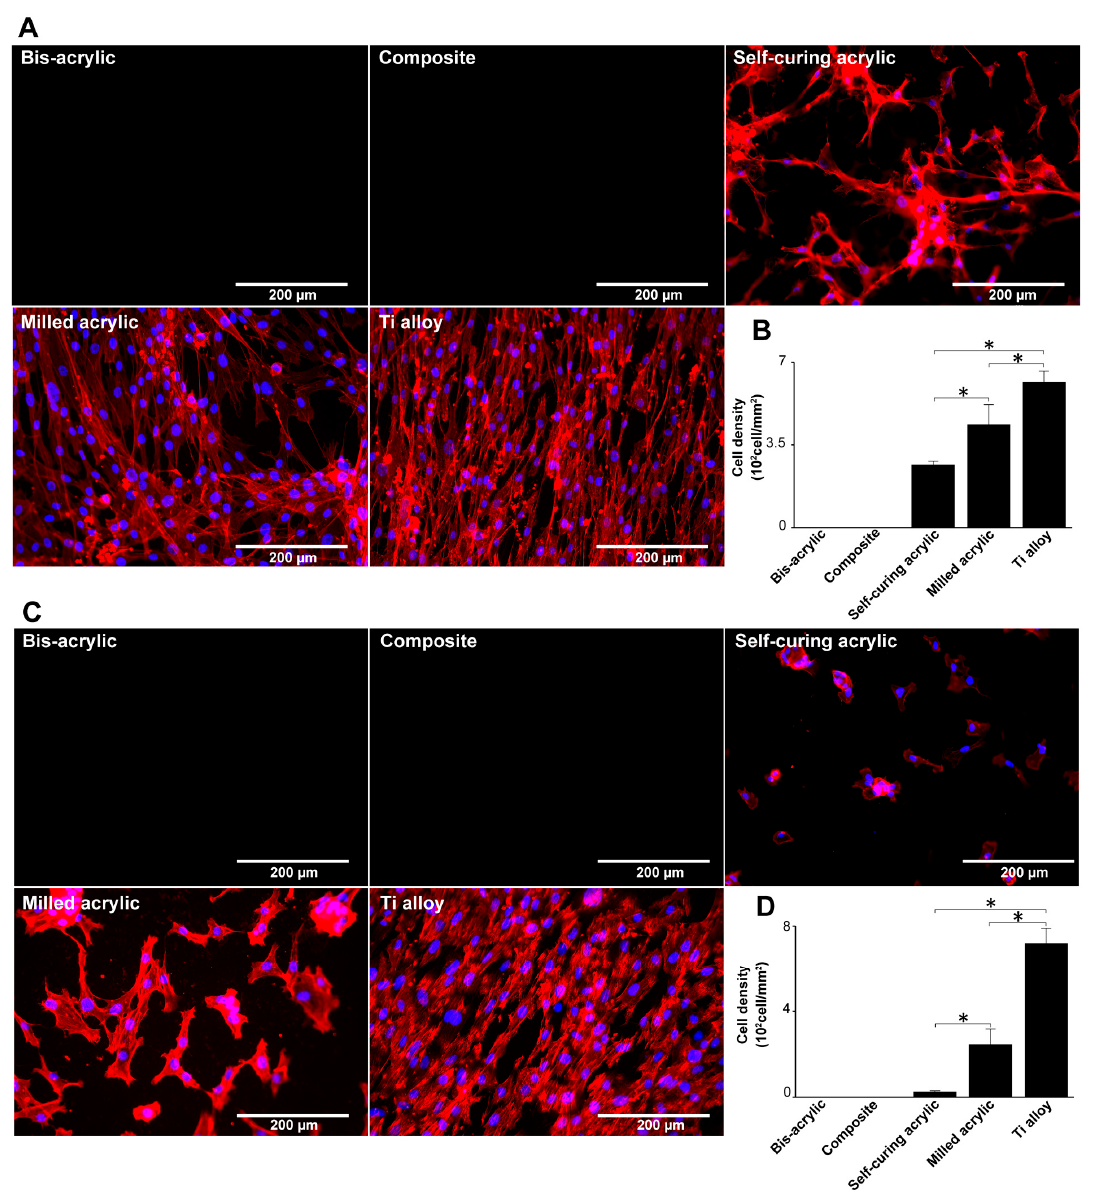
Figure 5. Visualization of fibroblasts and osteoblasts on test materials 4 days after seeding. ( A ) Fibroblasts were dual stained with DAPI for nuclei and rhodamine-phalloidin for actin filaments. ( B ) The number of fibroblasts in these images was counted to confirm the result in Figure 3A. ( C ) Osteoblasts stained similarly to fibroblasts. ( D ) The number of osteoblasts in these images was counted to confirm the result in Figure 3C. Data shown are means ± SD (n = 3). Significant differences are shown (one-way ANOVA with the Bonferroni post hoc test, * p < 0.05).